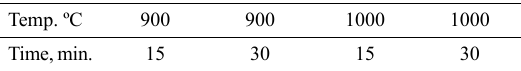
Table 1. Time and temperature for heat treatment of rolled samples.